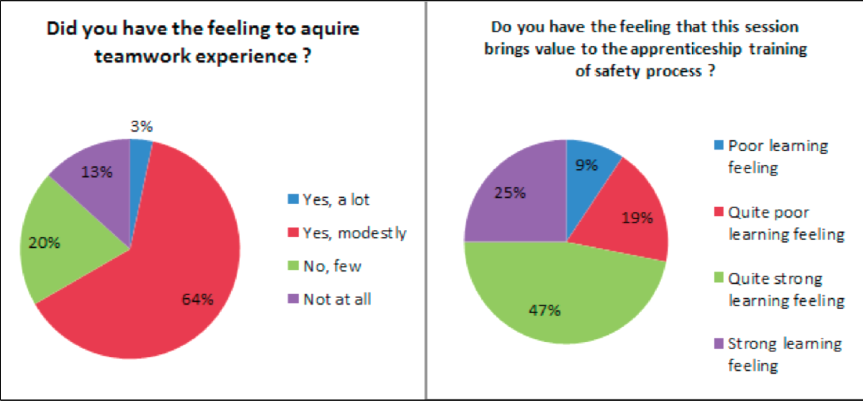
Fig. 3. Questions were asked to students about their feeling on the training